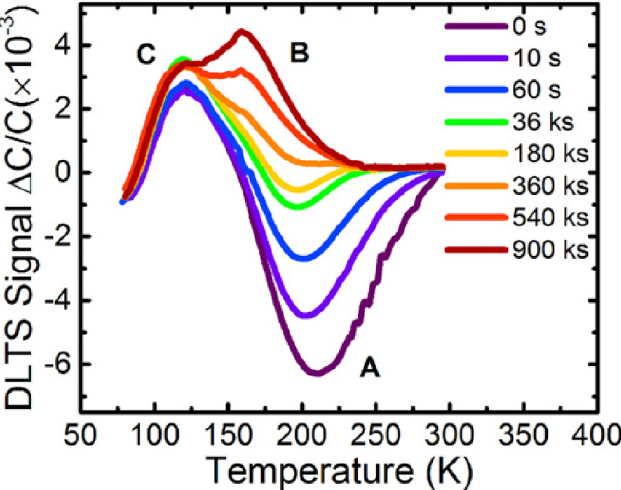
Figure 15. DLTS spectra of UV-C LED measured under a reverse bias of − 6 V. Reproduced with permission. [64] Copyright 20120, AIP.